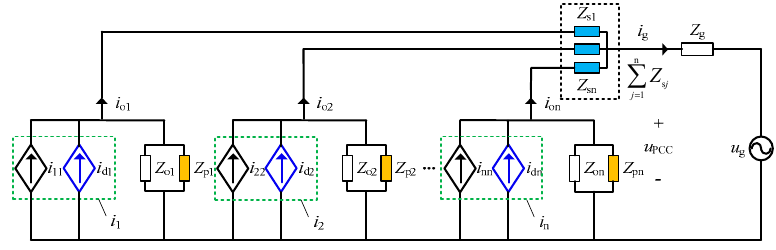
Figure 5. Refined equivalent output impedance model.